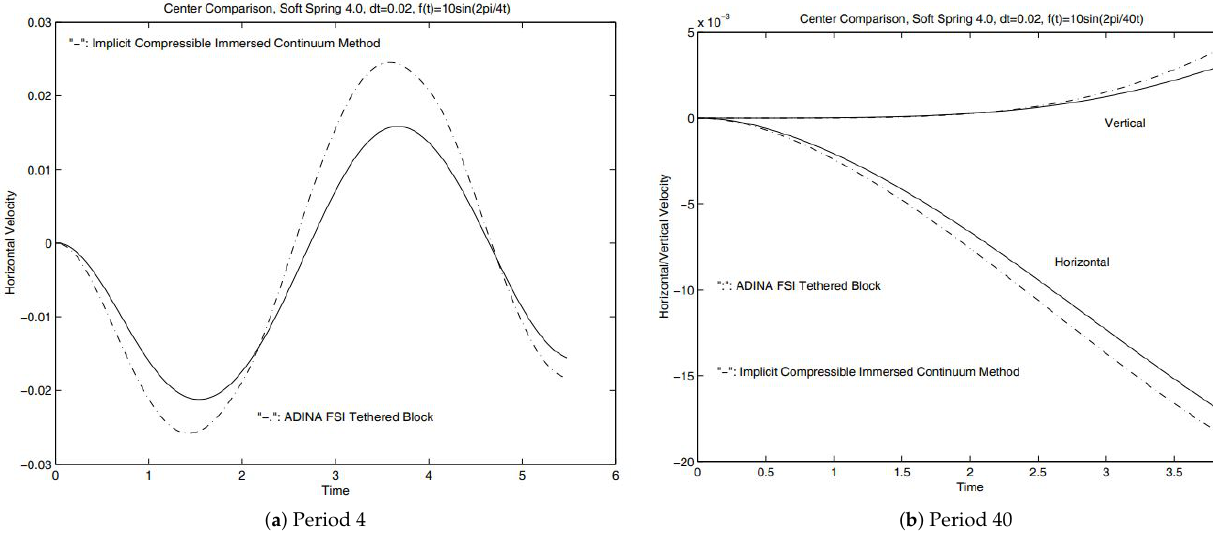
Figure 9. A comparison of horizontal and vertical velocities derived from the traditional ALE formulation and the immersed methods.